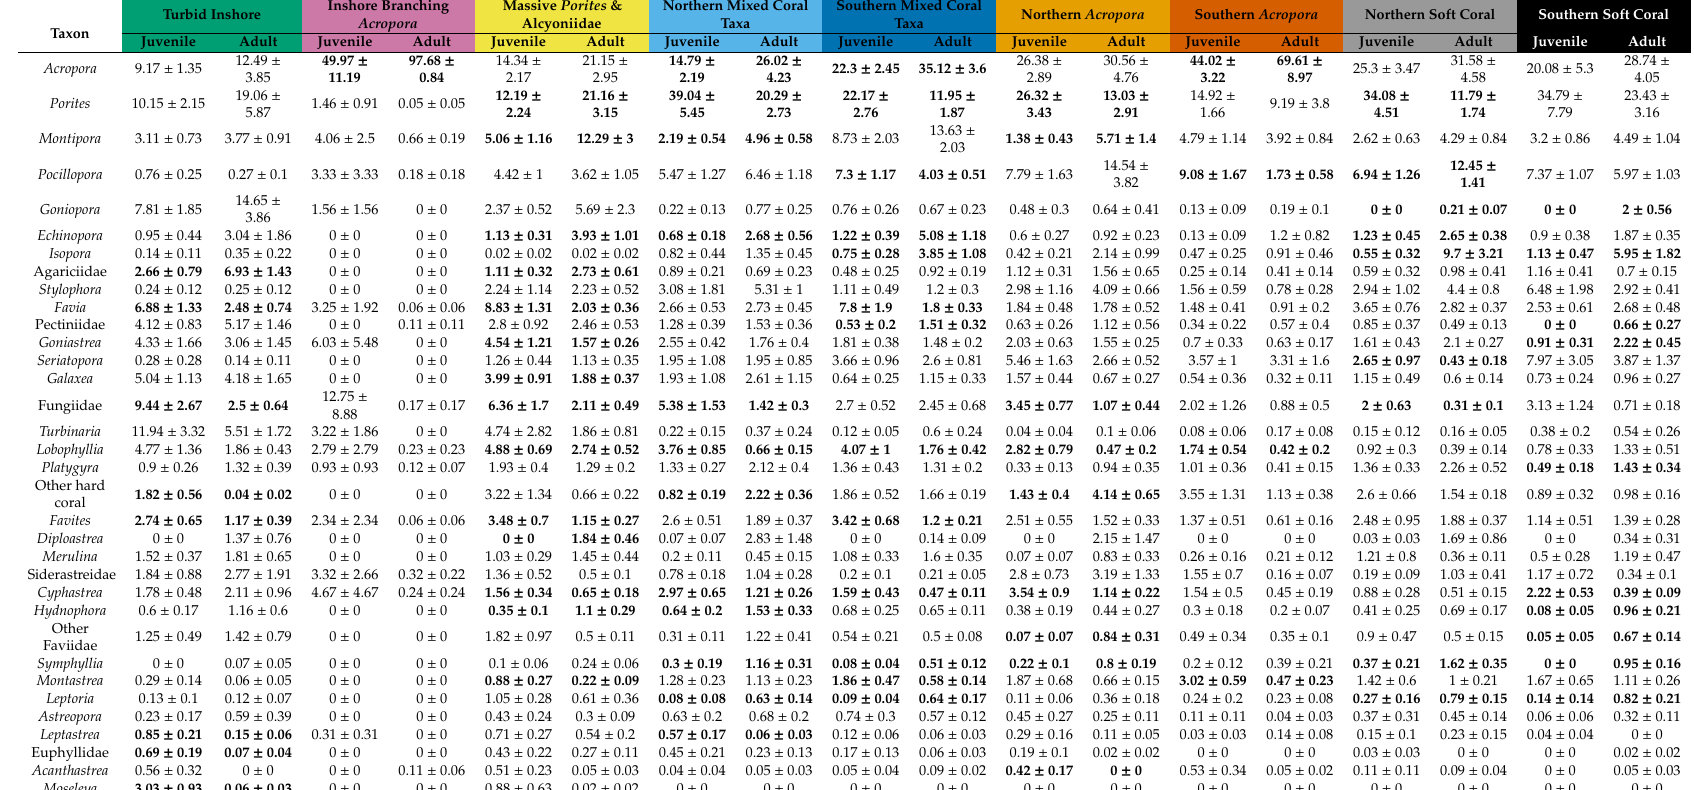
Table A2. Relative abundances of juvenile and adult coral taxa (mean ± se) by community type. Bold values represent significant t -tests ( p < 0.05) between juvenile and adults per